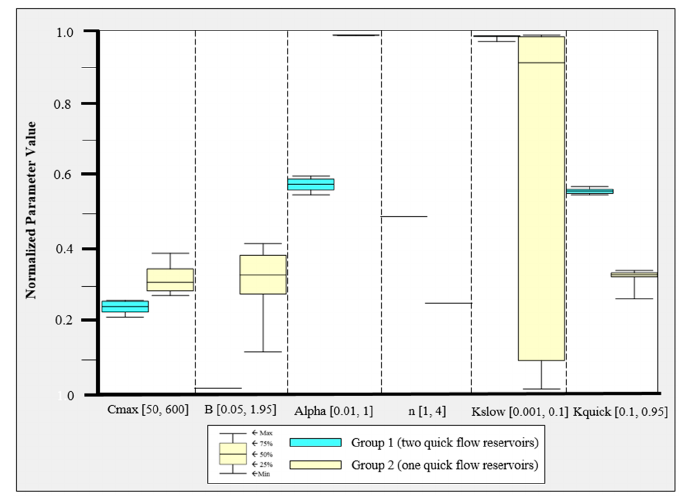
Figure 9. Normalized parameter ranges of the global Pareto solutions obtained by the variable balancing approaches.